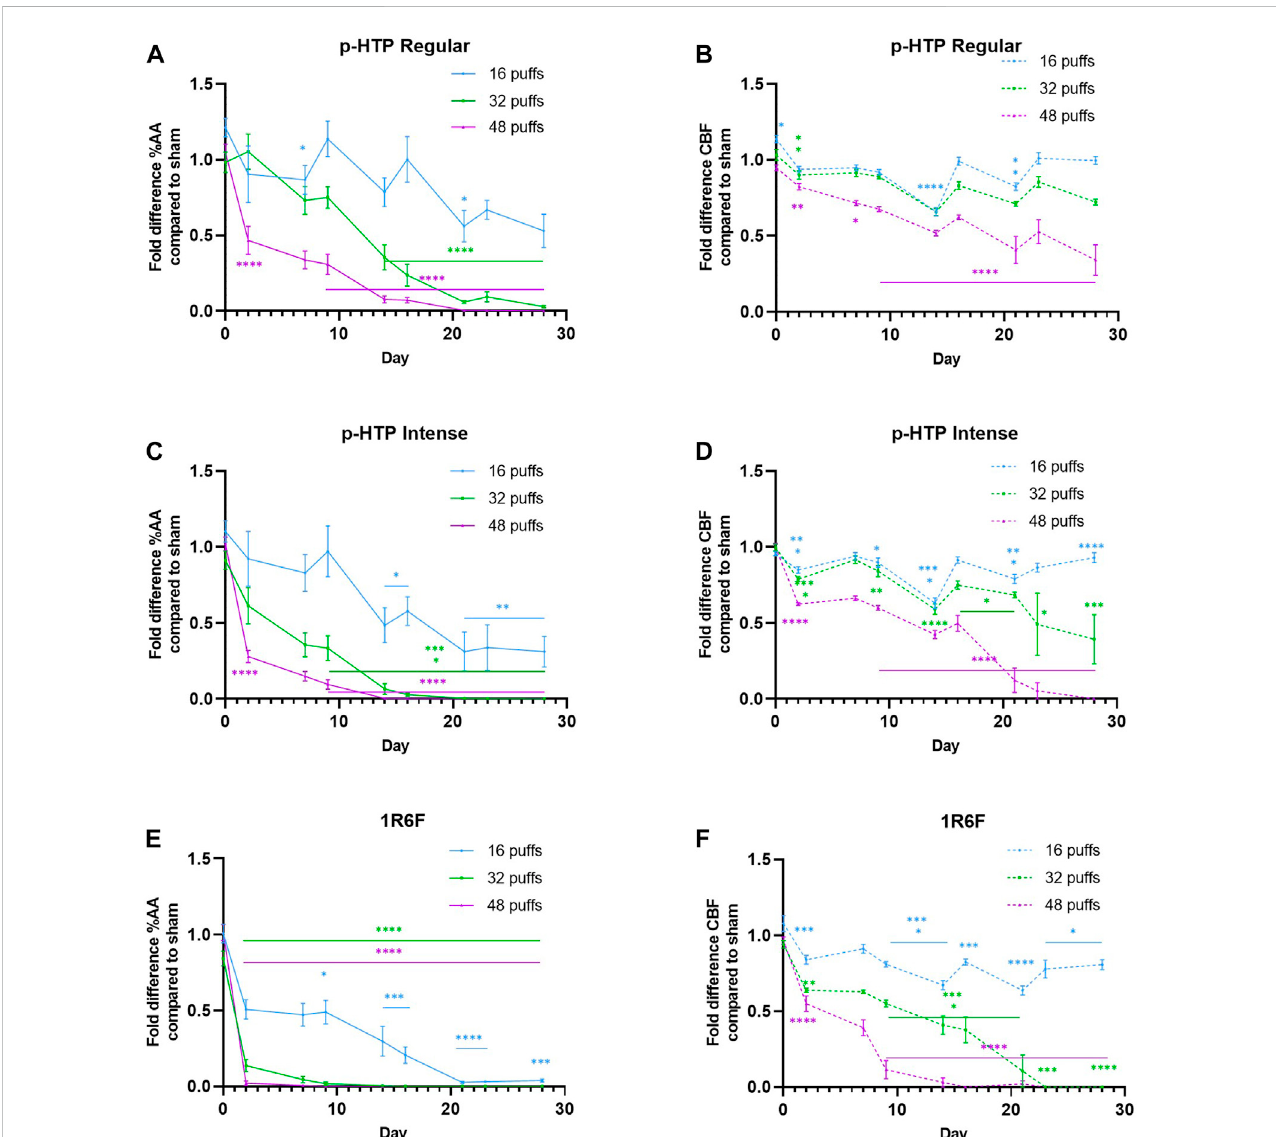
FIGURE 4 (A,C,E) Foldchangesin%ciliaactivearea(AA)comparedtosham(air)treatmentof3Dbronchialtissuemodelsexposedto16,32or48puffsofaerosolor smoke (B, D, E) Fold changes in cilia beat frequency (CBF) compared to sham (air) treatment of 3D bronchial tissue models exposed to 16, 32 or 48 puffs of aerosol orsmoke. Error bars represent standarddeviation;Sham: up to day17, n =5, day 15onwards, n = 3;testproducts: up to day 17, n = 8, day15 onwards, n = 5 (some tissues were lysed for analyses on day 17). * p ≤ 0.05; ** p ≤ 0.01; *** p ≤ 0.001; **** p ≤ 0.0001 (ordinary one-way ANOVA with Bonferroni ’ s post-hoc